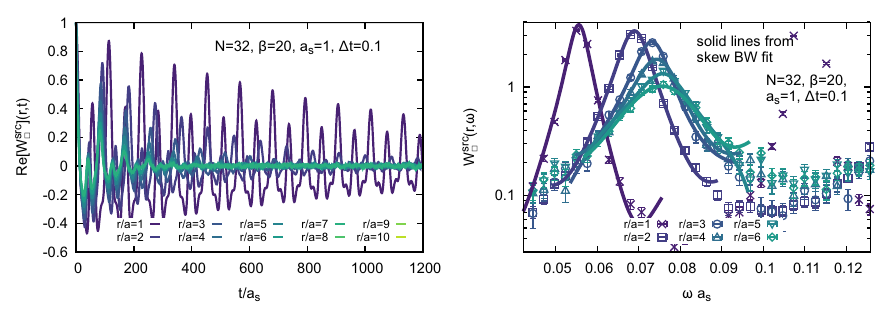
Figure 2. (left) Real part of the real-time Wilson loop in CLGT in the presence of the proper Gauss law. Note the both oscillatory and damped component of the evolution. Its imaginary part shows a similar oscillatory pattern. (right) The spectral function of the real-time Wilson loop, which exhibits a well-defined low-lying peak of skewed-Lorentzian shape. Figures from [35].